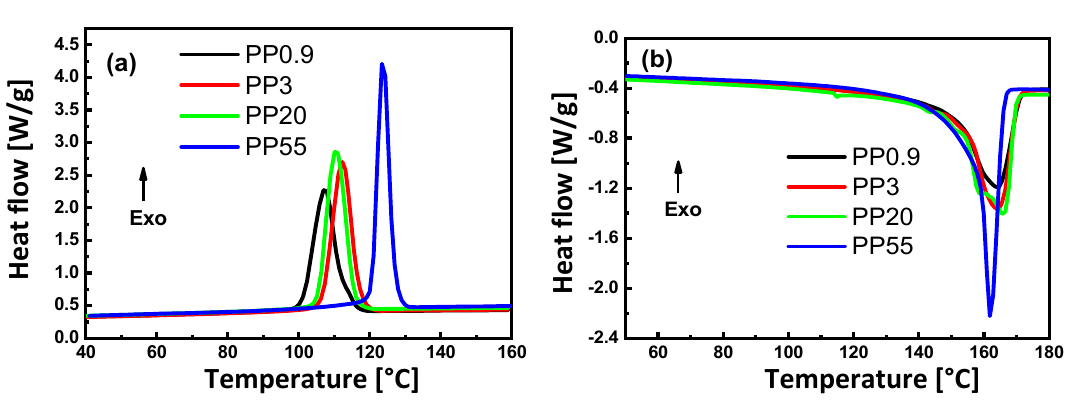
different viscosities. ( a ) DSC thermograms showing the crystallization behavior, and ( b ) DSC thermograms showing the melting behavior.